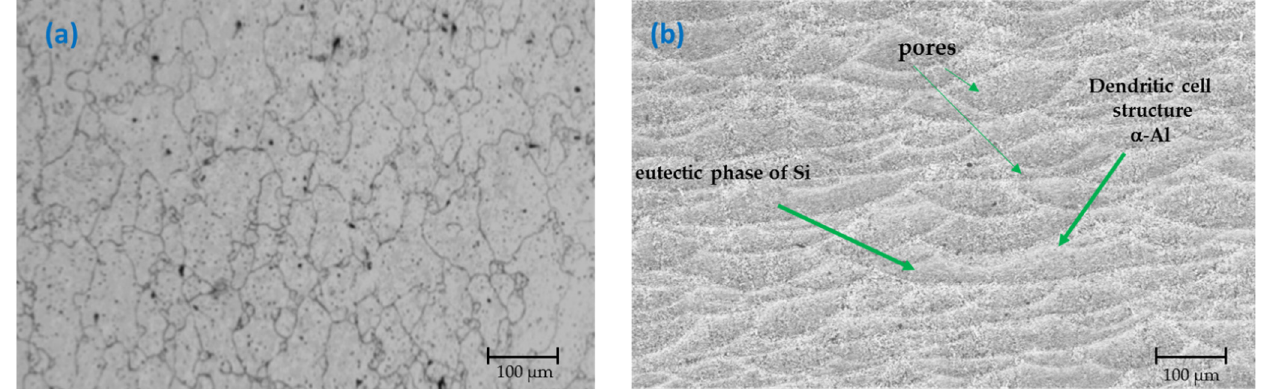
Figure 1. OM micrograph of alloys (initial conditions); ( a ) Al-6061 and ( b ) AlSi10Mg (Al-A.M).